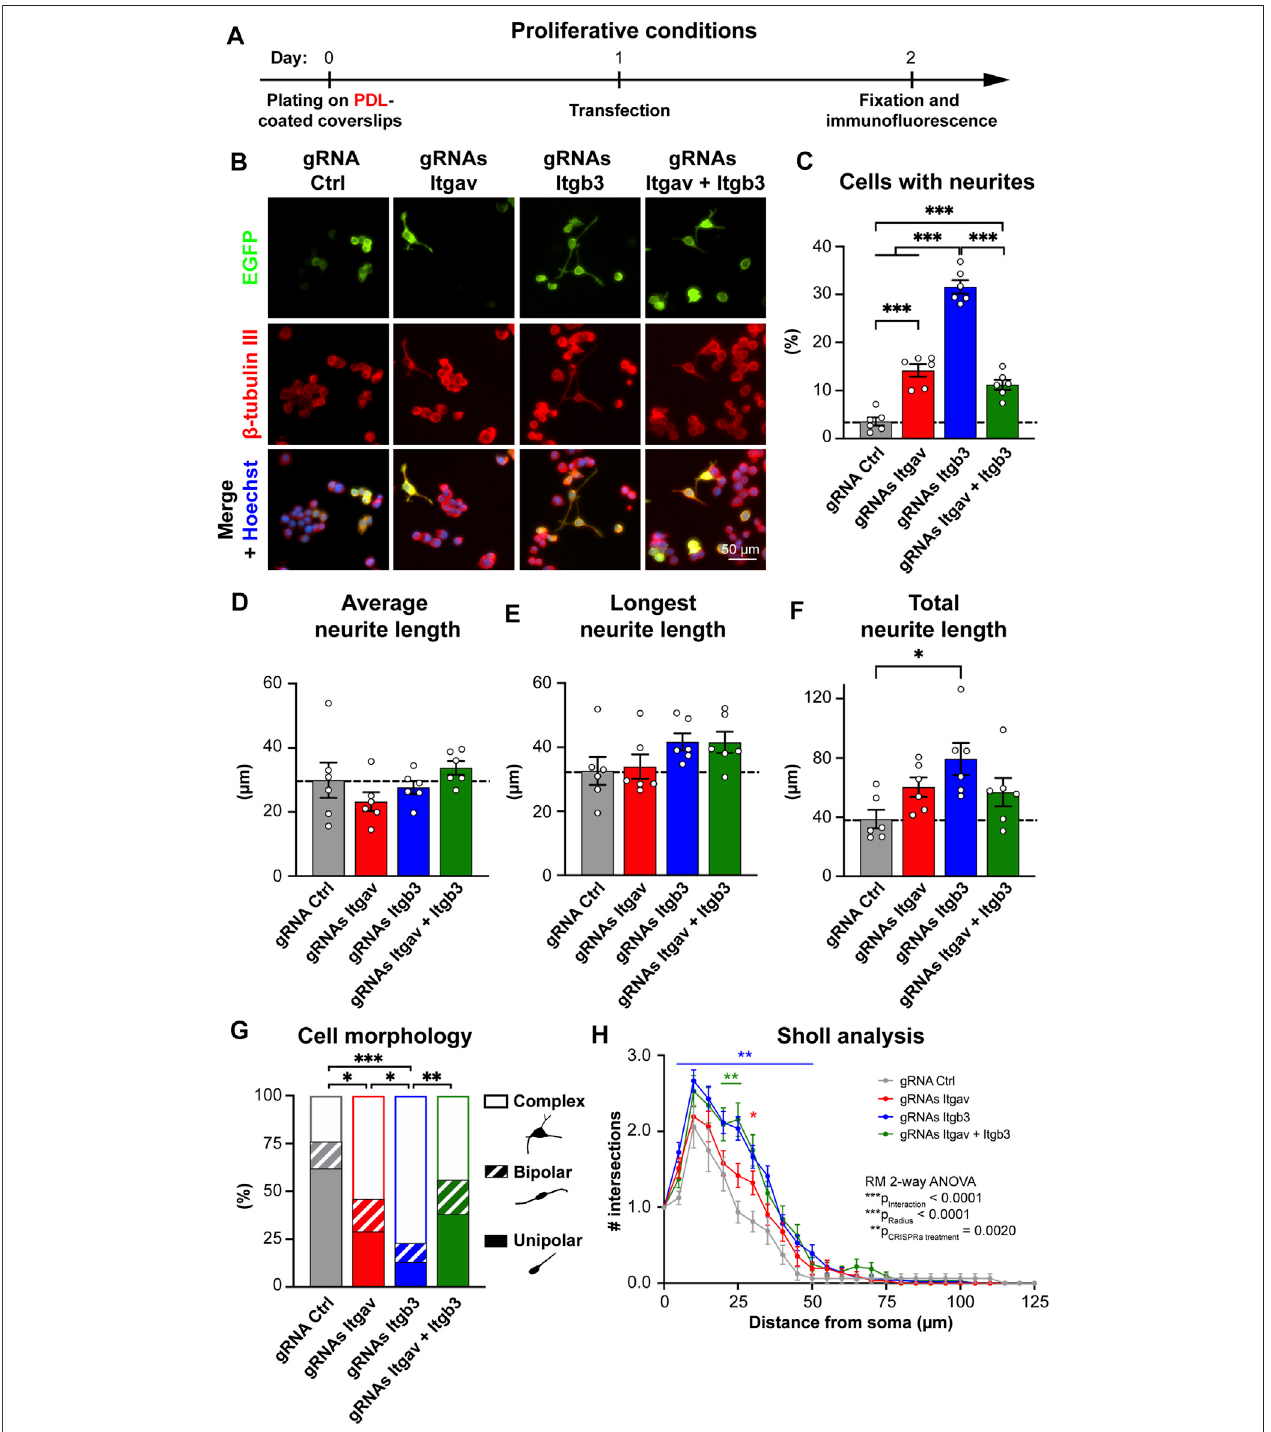
FIGURE 2 | CRISPR-mediated activation of Itgav and Itgb3 triggers N2a cell differentiation under proliferative conditions. (A) Time course of the experiment. (B) Representative images of N2a cells expressing the indicated constructs. Transfection was veri fi ed by EGFP expression, β -tubulin III staining was used to trace neurites and Hoechst to stain nuclei. (C) Percentage of cells with neurites within EGFP-positive cells for experiments as in (A,B) . *** p < 0.001, one-way ANOVA followed by Tukey ’ s post-test ( n = 6 coverslips from four independent experiments). CRISPRa for either Itgav or Itgb3 or both induces differentiation of N2a cells; CRISPRa for Itgb3 aloneistwiceaseffectiveasCRISPRafor Itgav aloneorCRISPRafor Itgav and Itgb3 . (D – F) Average (D) ,longest (E) andtotalneuritelength (F) ofdifferentiatedN2a cellsexpressing theindicatedconstructs. * p < 0.05,one-wayANOVAfollowedbyTukey ’ spost-test( n =6coverslipsfromfourindependent cultures). (G) Morphological